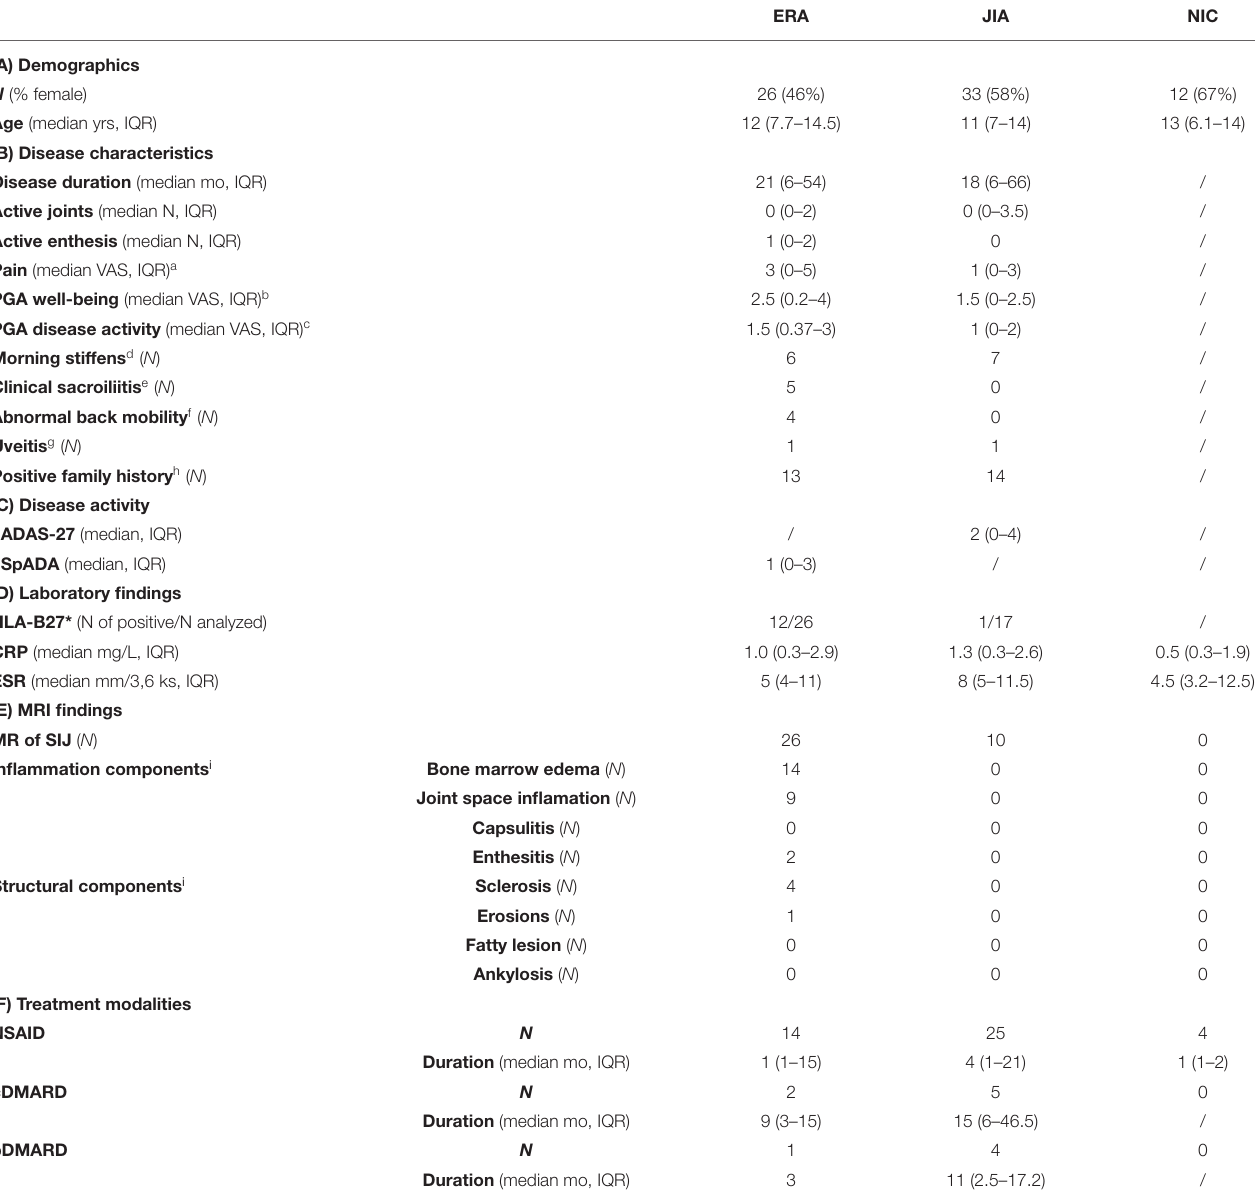
TABLE 1 | Demographic data (A) , disease characteristics (B) , laboratory (C) and MRI (D) findings, and treatment modalities (E) of study participants.